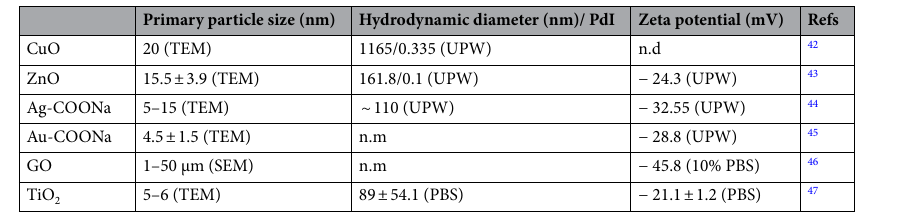
Table 1. Characteristics of the investigated